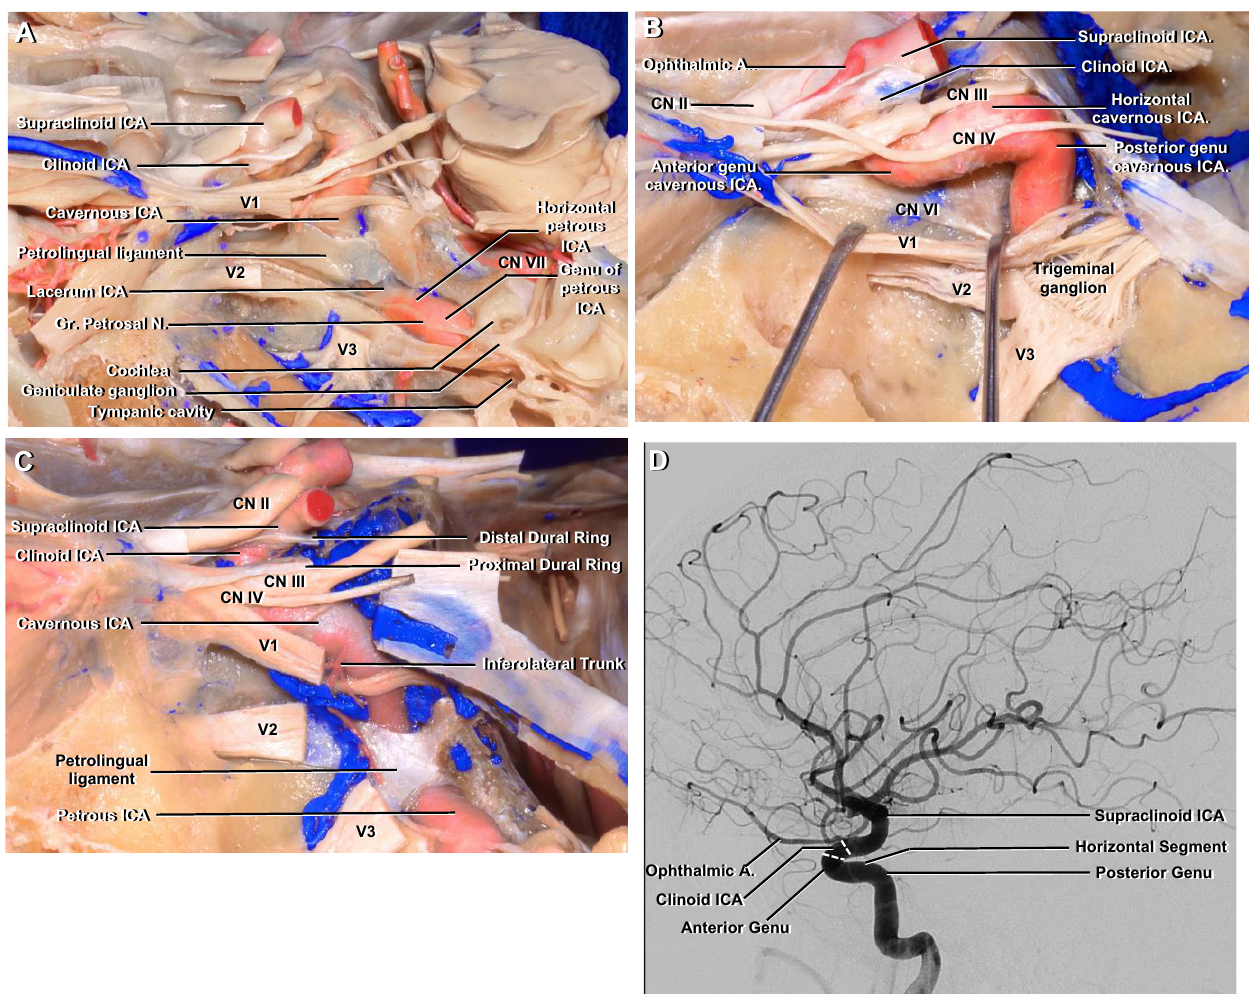
Figure 2. Left middle fossa and cavernous sinus. ( A ) The dura of the middle fossa floor has been removed and part of the trigeminal ganglion and its 3 divisions has been cut. It is possible to appreciate an ossified petrolingual ligament. The petrous ICA is positioned lateral to the trigeminal nerve, and the greater petrosal nerve courses above its horizontal segment. ( B ) Another specimen. The ophthalmic nerve (V1) has been reflected inferiorly. The cavernous ICA is related laterally with the oculomotor, trochlear and ophthalmic nerves. The abducens nerve courses inferolaterally to the horizontal segment. ( C ) The cavernous ICA extends proximally from the upper margin of the petrolingual ligament inferiorly to the proximal dural ring superiorly. The inferolateral trunk arises from its horizontal portion. ( D ) Lateral ICA angiogram to be correlated with (B,C). It is possibly to identify a posterior genu, a horizontal segment and an anterior genu. Abbreviations: Gr., greater; A., artery; CN., cranial nerve. See Figure 1 for other abbreviations.